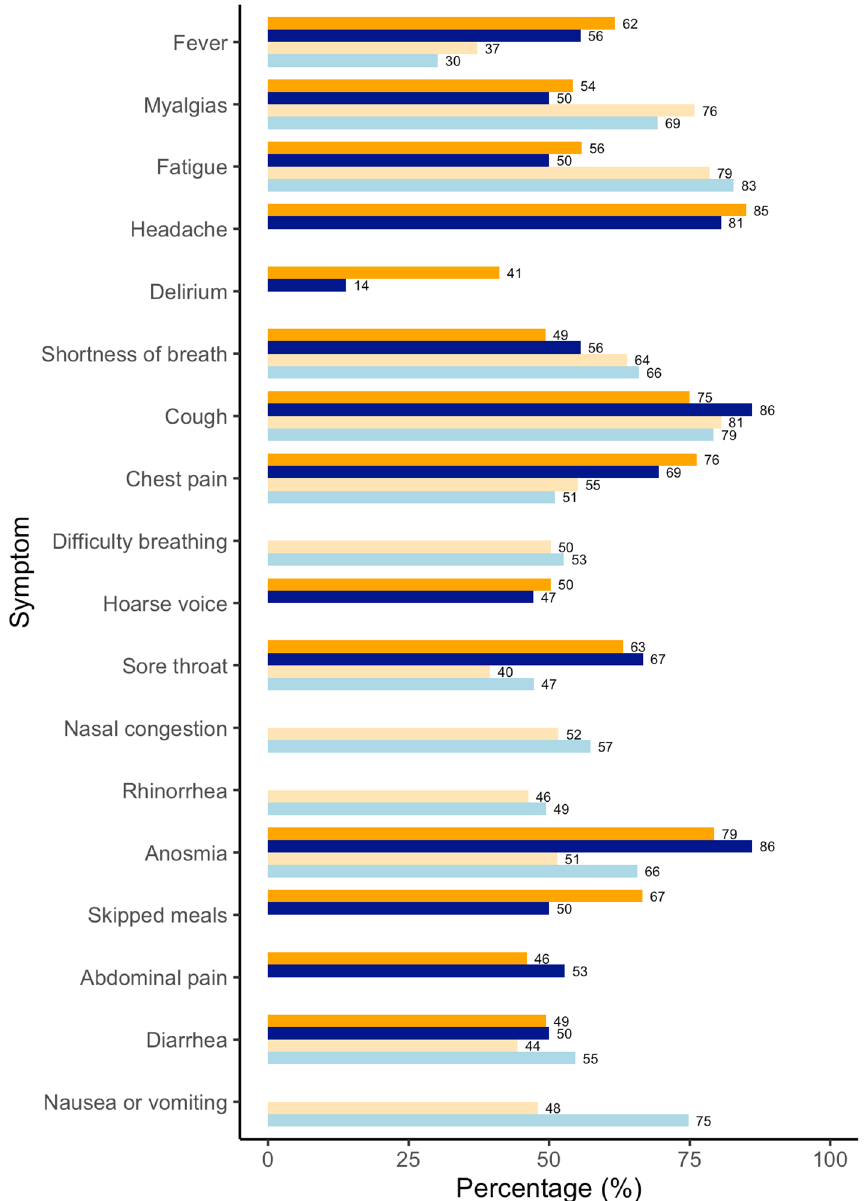
Figure 2. Comparison of symptoms presentation in the discovery (DC) and replication (RC) cohorts. Results refer to non-pregnant (orange) and pregnant (blue) women tested positive and suspected positive for SARS- CoV-2 and who required hospitalization (in DC, darker shade) or were seen at the hospital (RC, lighter shade). Results are reported as age-standardized percentage of women reporting each symptom in each